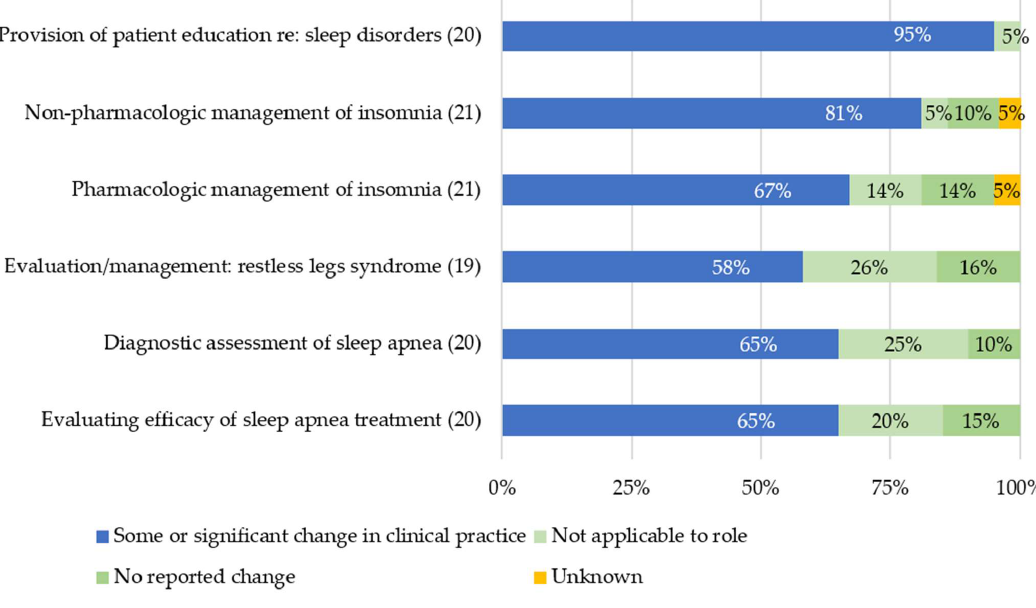
Figure 2. Self-reported change in clinical practice. Denominators, noted after each domain, exclude those who answered “did not attend a session related to this content”.